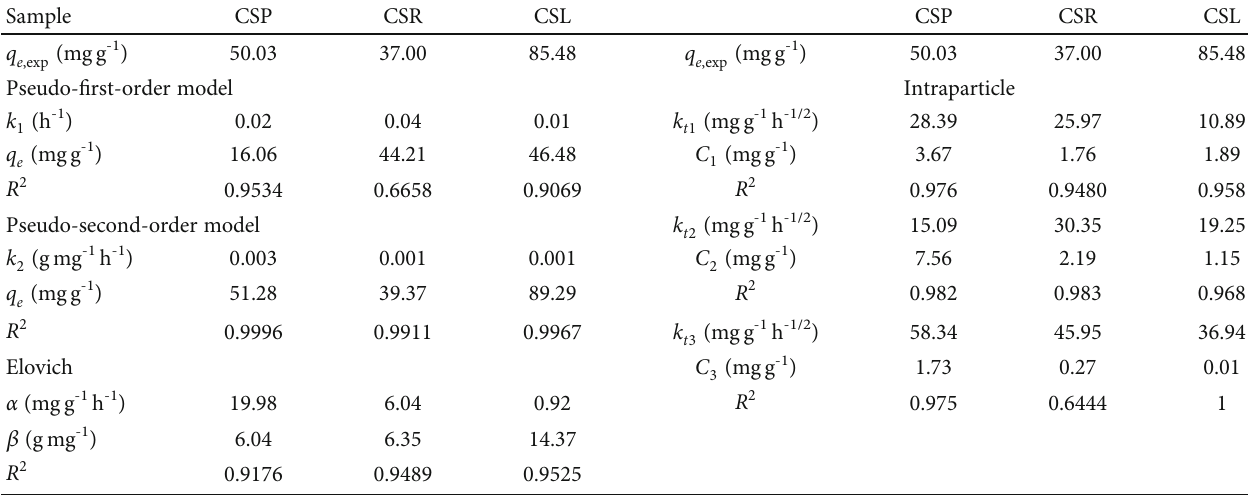
Table 5: Kinetic parameters for the adsorption of methylene